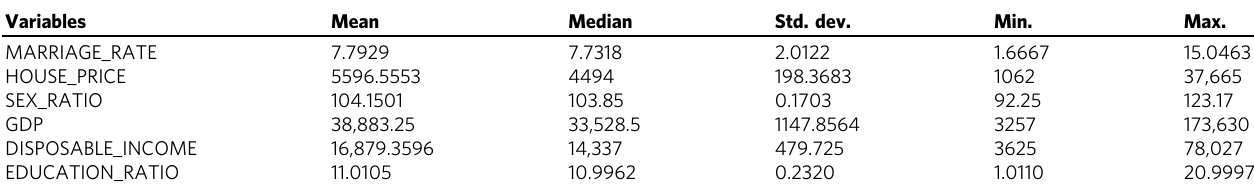
Table 2 Descriptive statistics of the